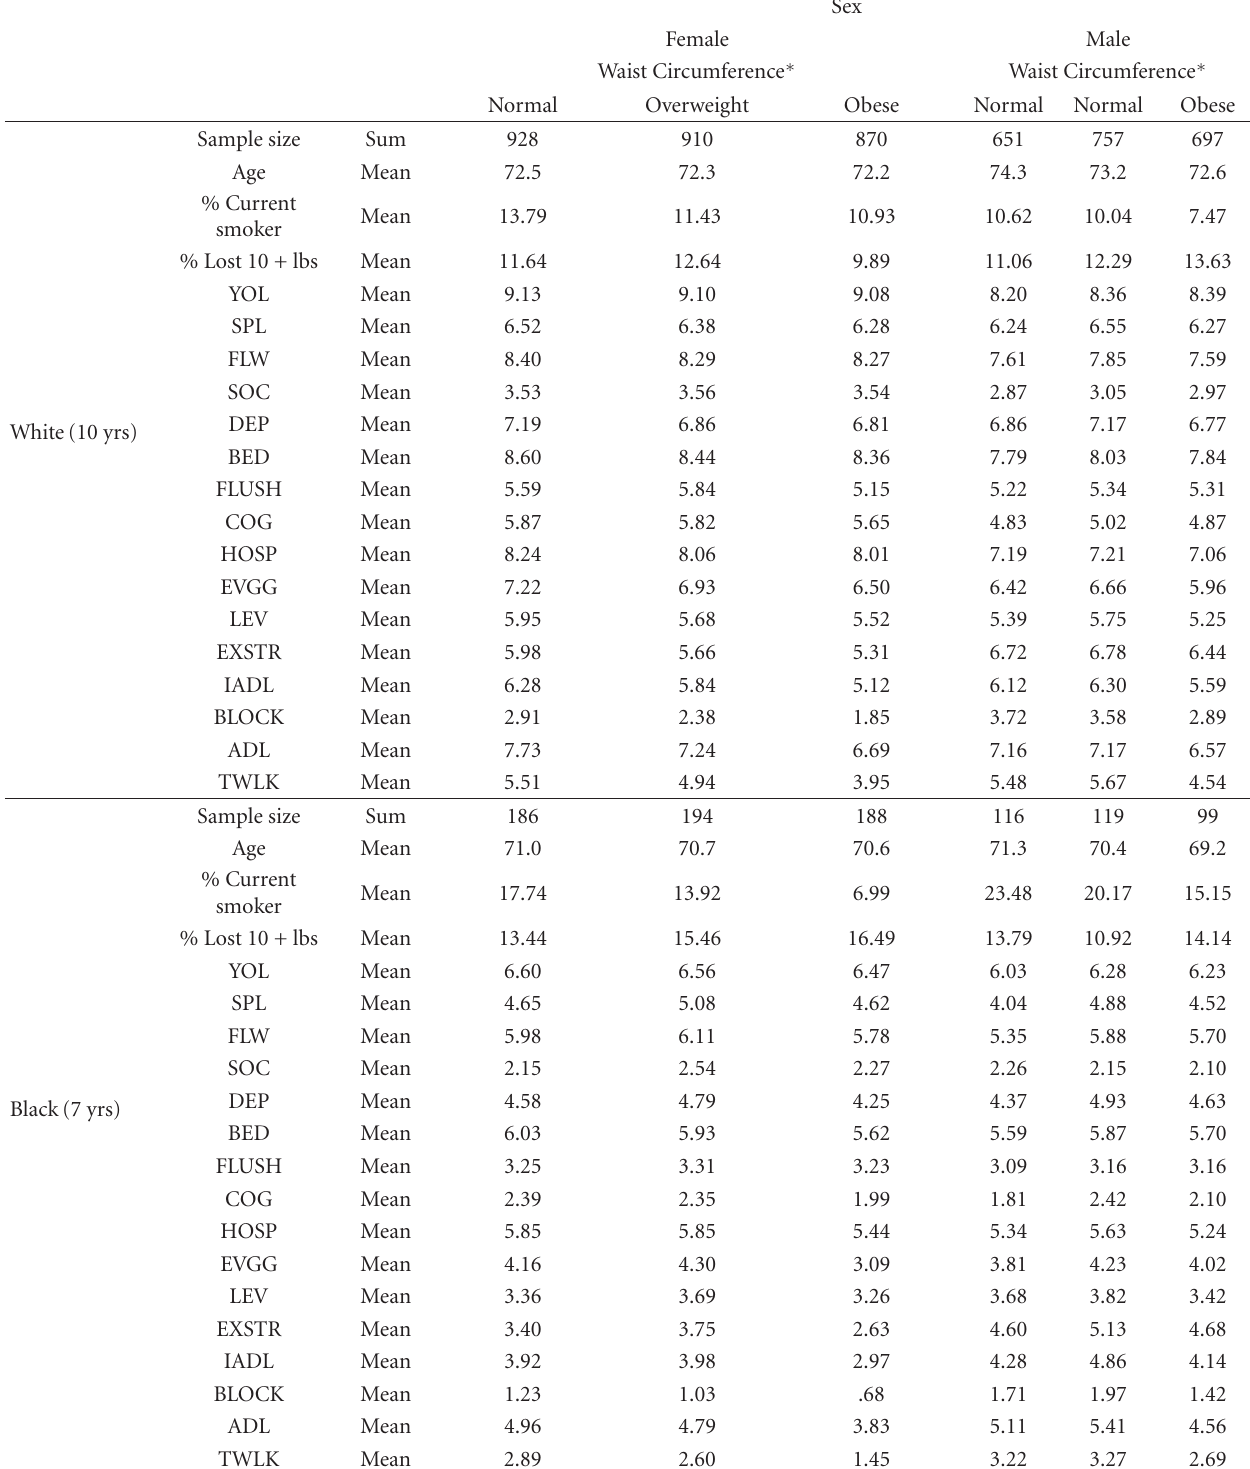
Table 6: Means by Waist Circumference ∗ , Gender and